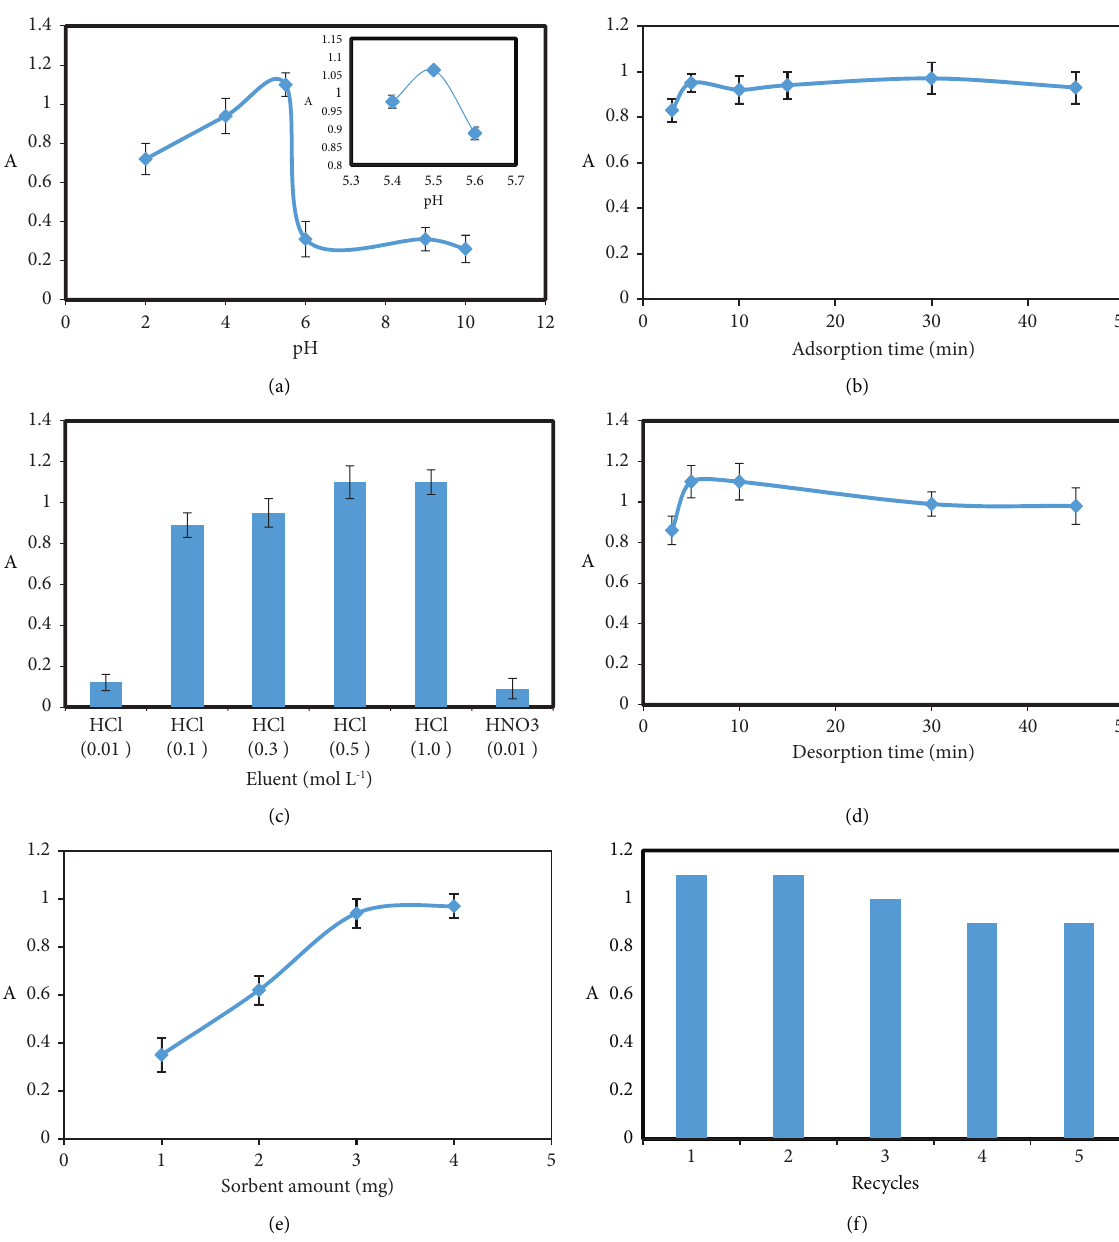
Figure 3: (a) Efect of sample solution pH. (b) Efect of adsorption time. (c) Efect of the type and concentration of eluent. (d) Efect of desorption time. (e) Efect of sorbent amount. (f) Reusability of the